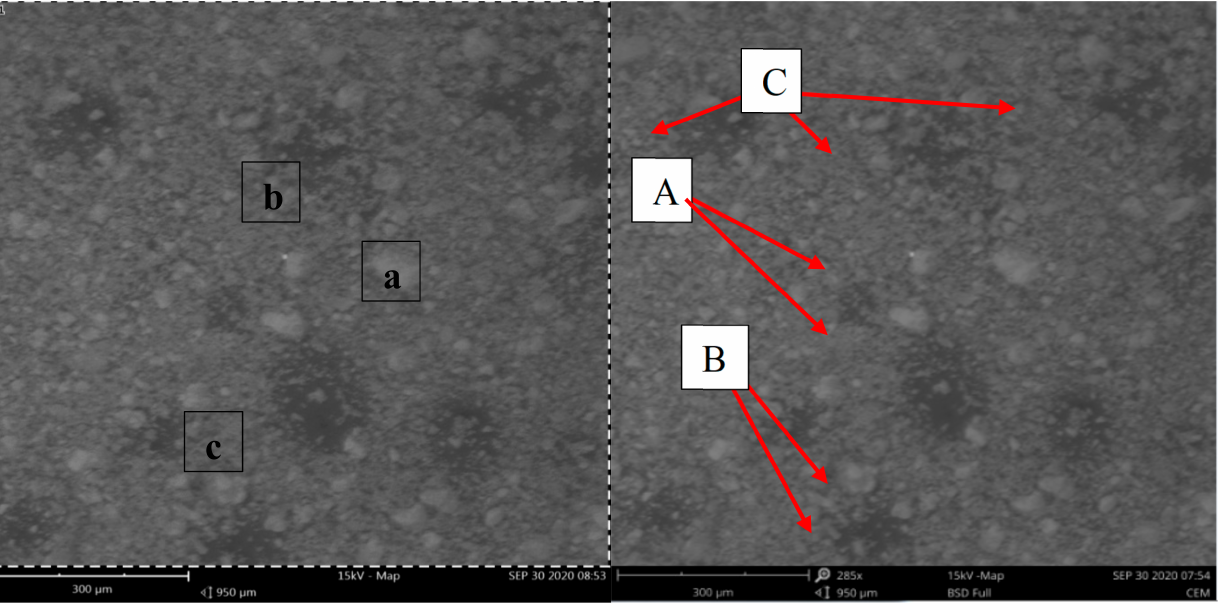
Figure 4. The SEM images of CEM II.